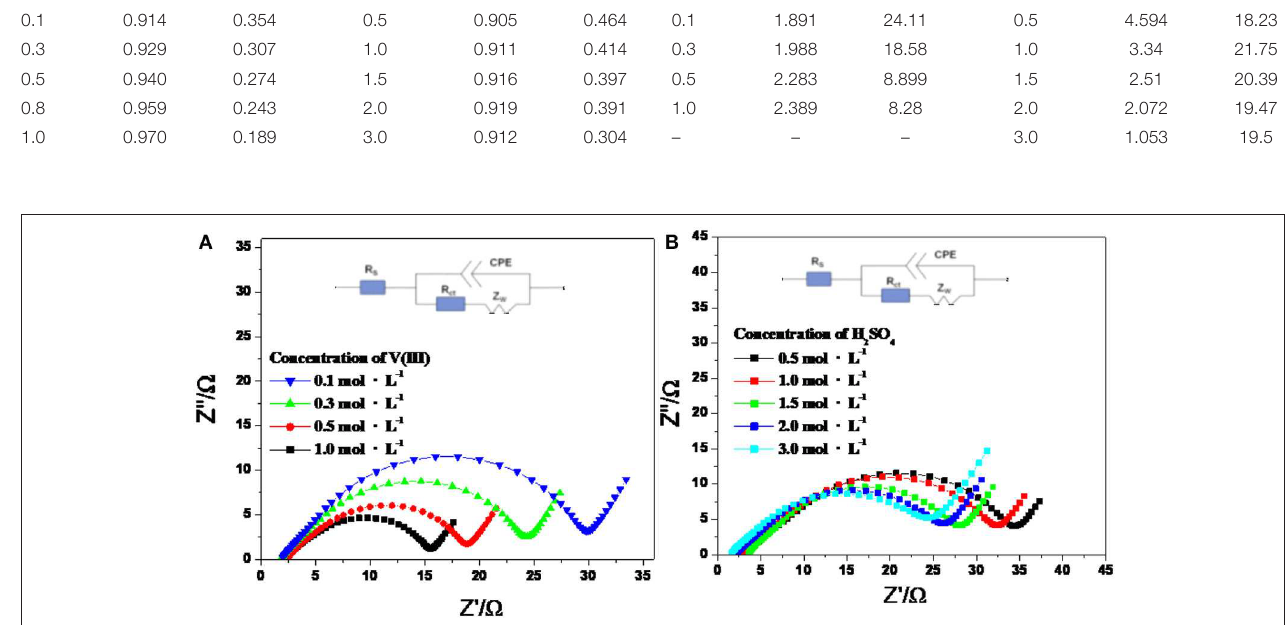
Frontiers in Chemistry |